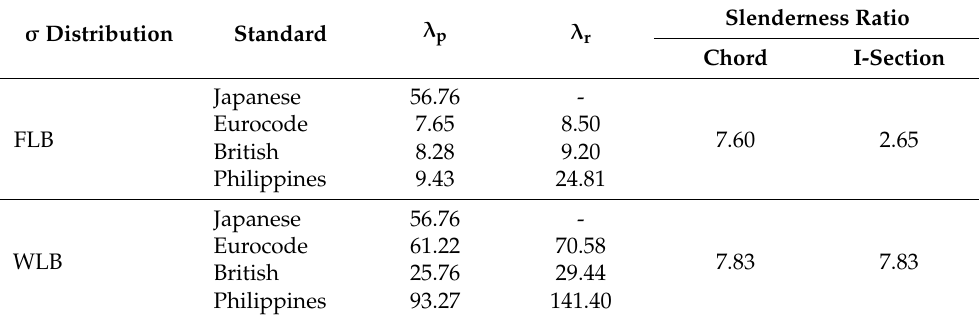
Table 4. Cross-sectional classification of critical